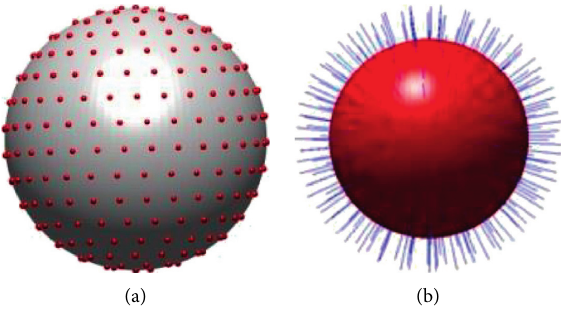
Figure 5: Uniform points on the discrete spheres and their Z- axis